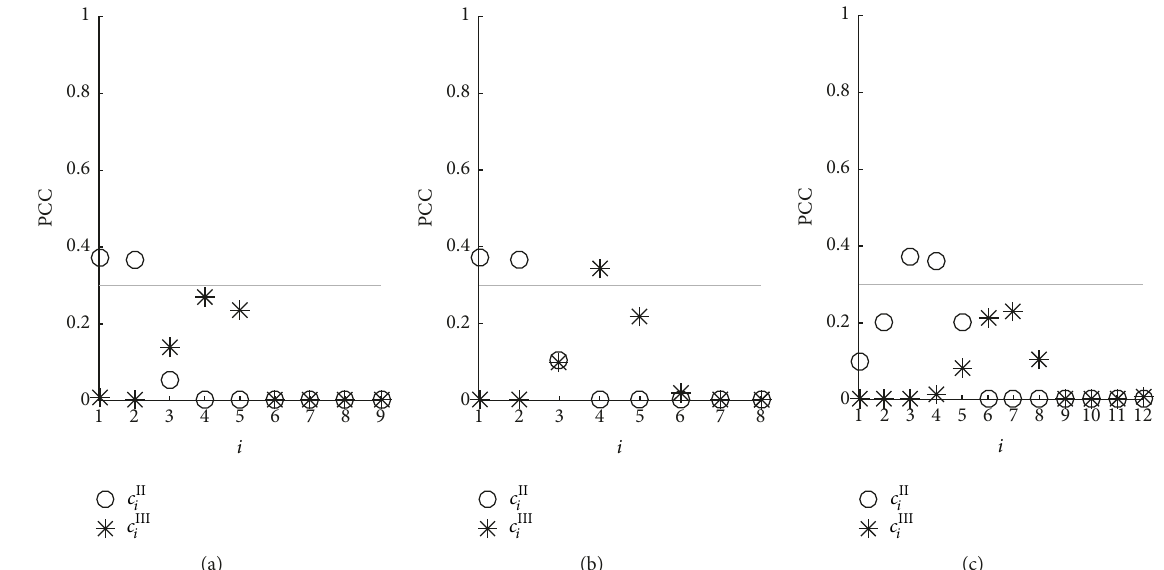
Figure 20: PCC values of Case 2 estimated taking into account (a) EMD, (b) EEMD, and (c) CEEMDAN.